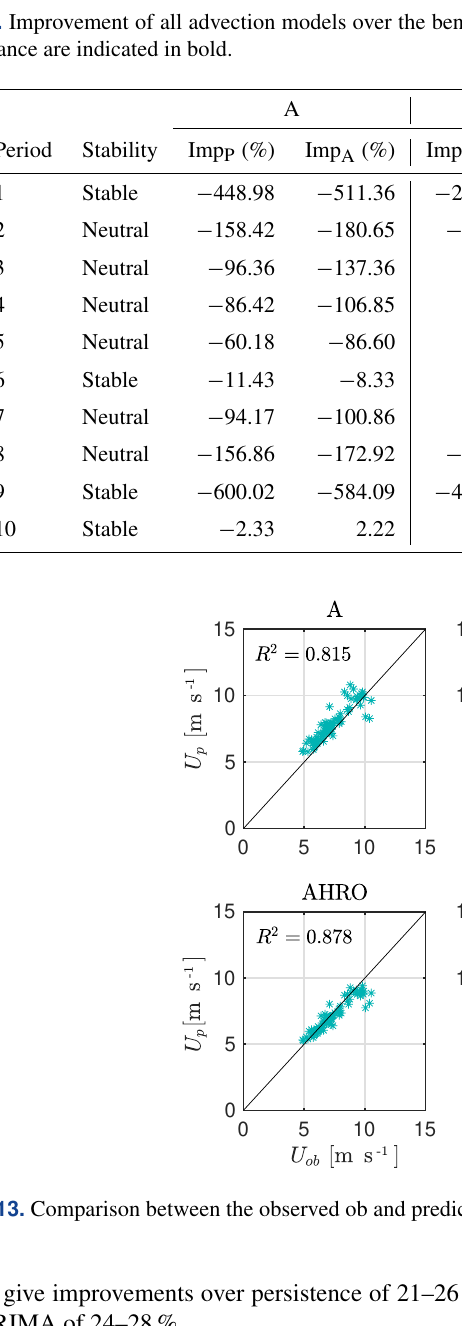
models give improvements over persistence of 21–26 % and over ARIMA of 24–28